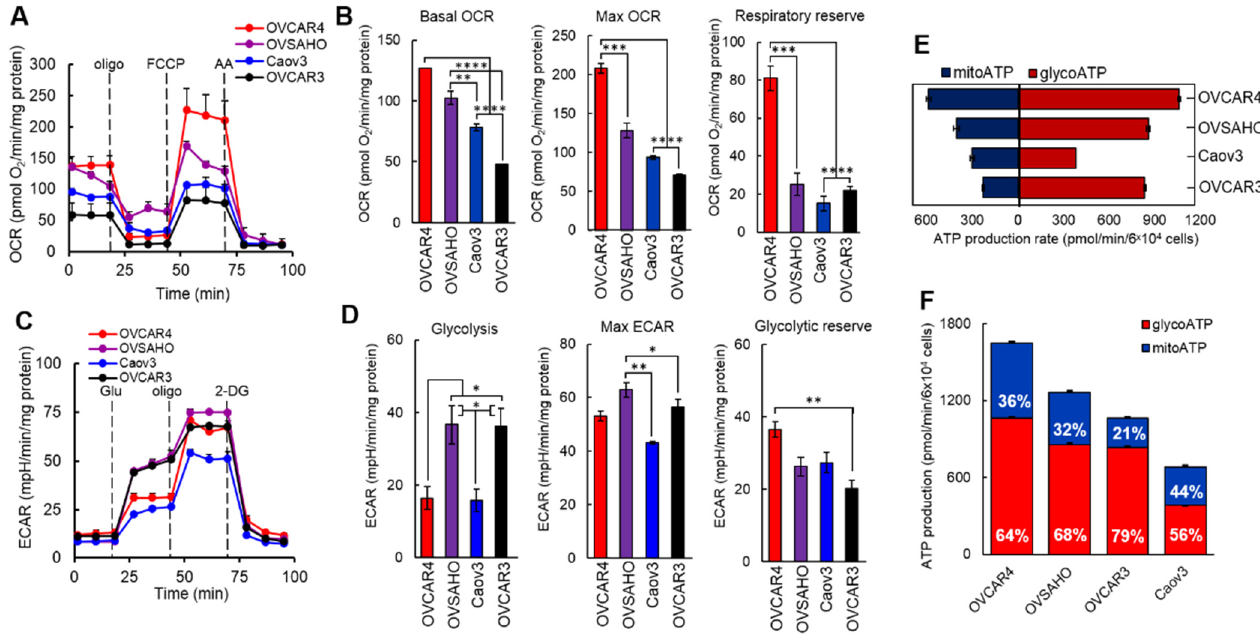
Figure 4. Bioenergetics profiles of ovarian cancer cell lines. ( A ) OCR was measured in ovarian cancer cell lines by the Seahorse XF Cell Mito Stress Test. Cells were challenged by oligomycin A “oligo”, FCCP, and antimycin A “AA”. ( B ) Basal OCR represents the mitochondrial respiration at resting state, the maximum respiration indicates the cellular response to an increased ATP demand, and respiratory reserve indicates the cell capacity to utilize mitochondria during periods of high-energy expenditure. Data are represented as mean ± SEM, illustrating differences in OCR between cell lines (unpaired t -test, **** = p < 0.0001, *** = p < 0.001, ** = p < 0.01). ( C ) ECAR was measured in ovarian cancer cell lines by the Seahorse XF Glycolysis Stress Test. Cells were challenged by glucose, oligomycin A, and 2-DG. ( D ) Increase in ECAR in response to glucose represents a rate of glycolysis under basal conditions, maximal ECAR represents the cellular maximum glycolytic capacity, and glycolytic reserve defines the capacity to increase glycolysis when mitochondria are compromised. Data are represented as mean ± SEM, illustrating differences in ECAR between cell lines (unpaired t -test, ** = p < 0.01 * = p < 0.05). ( E ) Seahorse XF Real-Time ATP Rate Assay was performed using ovarian cancer cell lines revealing OCR-linked (mitoATP) and ECAR-linked (glycoATP). Graph shows ATP production rates in basal conditions. ( F ) Graph represents a distribution of mitochondrial and glycolytic ATP production rates represented as % of mitoATP and % of glycoATP. All Seahorse experiments were performed for a minimum of 2 times in